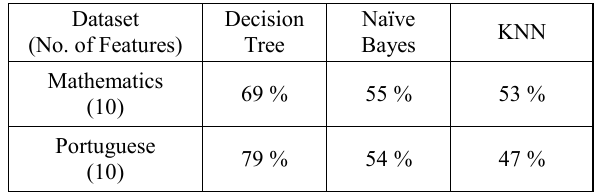
Table 2B. Prediction accuracy with single feature selection